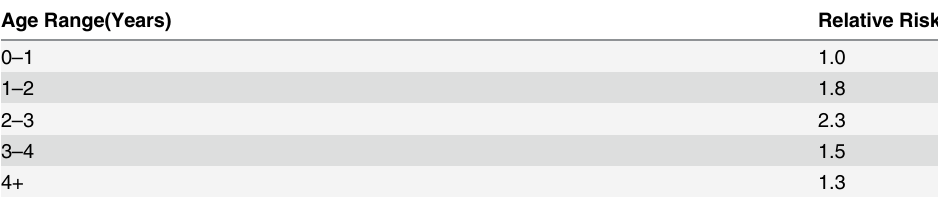
Table 1. Relative Risk of Infection